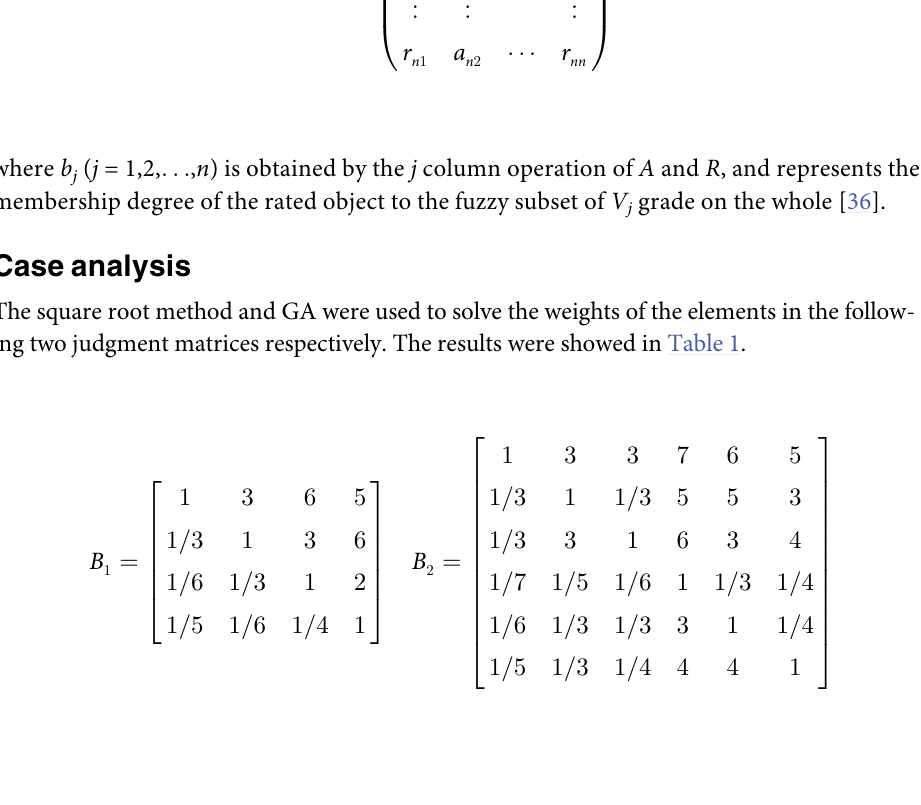
It can be seen from the weight calculation results of the two judgment matrices in Table 1, that the weight obtained by the GA was more accurate than the square root method. The con- sistency test coefficient obtained by the square root method are 0.1136 and 0.1054, cannot make B and B pass the consistency test, because they are more than 0.1. While the result 1 2 obtained by GA are 0.0321 and 0.0433, can make B and B pass the consistency test. 1 2 Weight calculation and matrix correction were performed simultaneously when GA is � and B � are the final correction matrices of B applied. The following matrices B and B . We 1 2 1 2 � and B � is significantly better than that of matrices can see that the consistency of matrices B 1 2